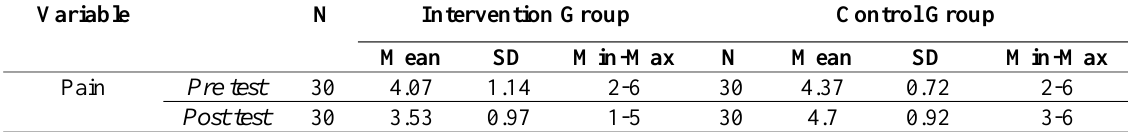
Table 2: Differences in pain of cancer patients in intervention group and control (n: 60) Variable